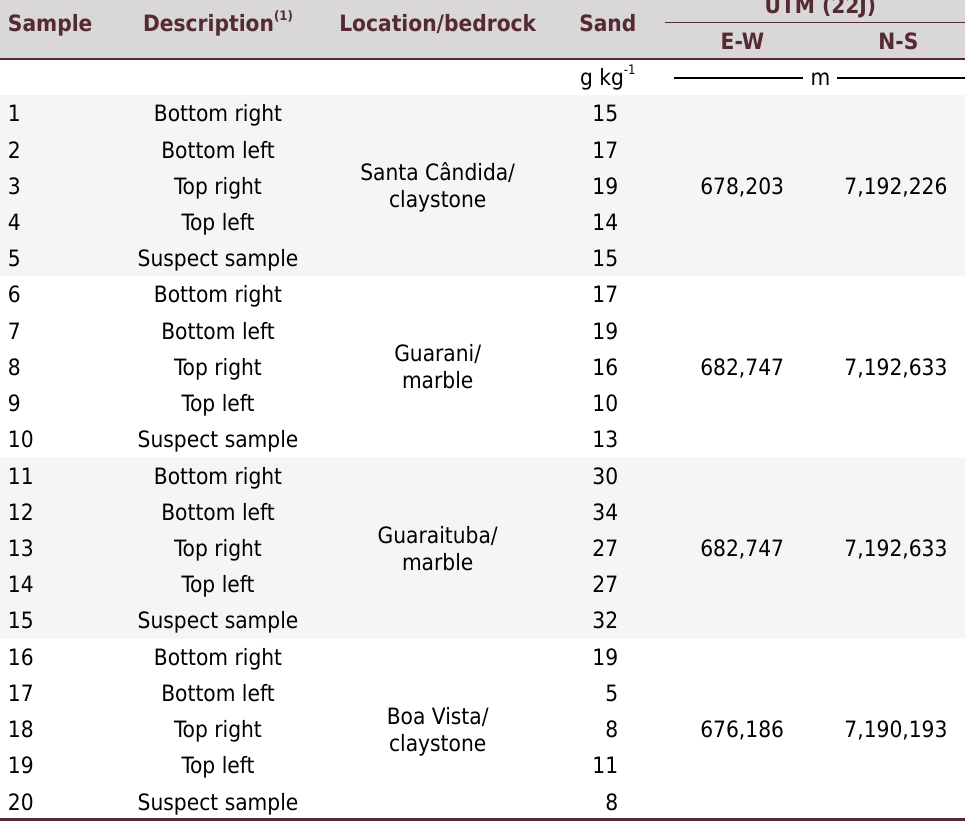
Table 1. Sites description, locations, and sand contents of selected